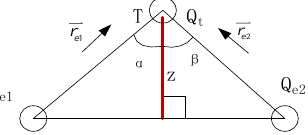
Figure 3. Schematic of electric field vector.